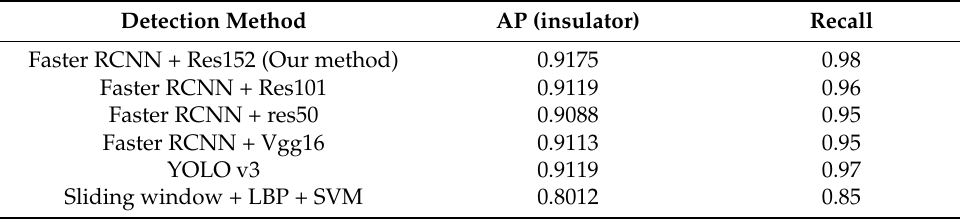
Table 2. Comparison with other target detection methods.